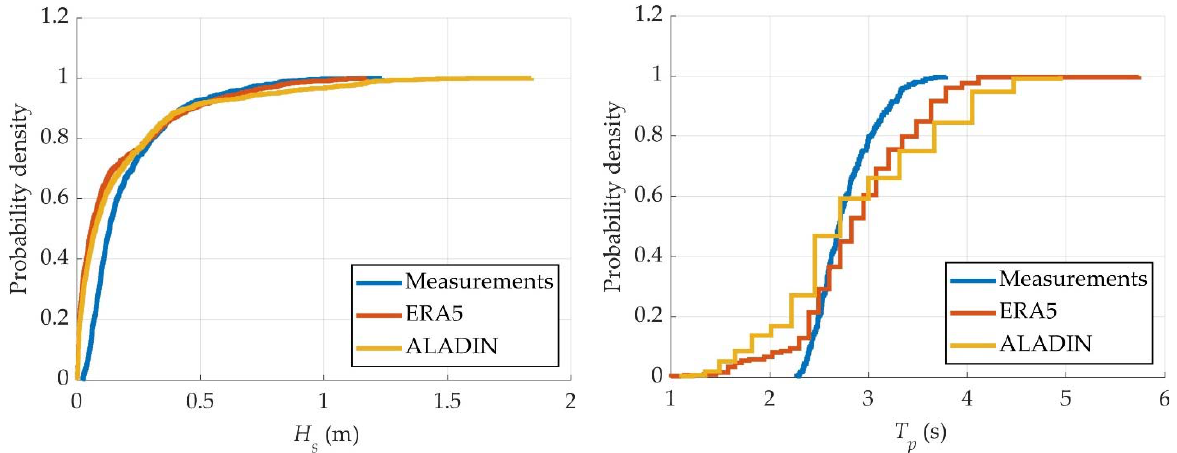
Figure 12. Empirical CDF comparing ( left ) measurements, ERA5 forced model significant wave heights and ALADIN forced model significant wave heights ( right ) measurements, ERA5 forced model peak wave periods and ALADIN forced model peak wave